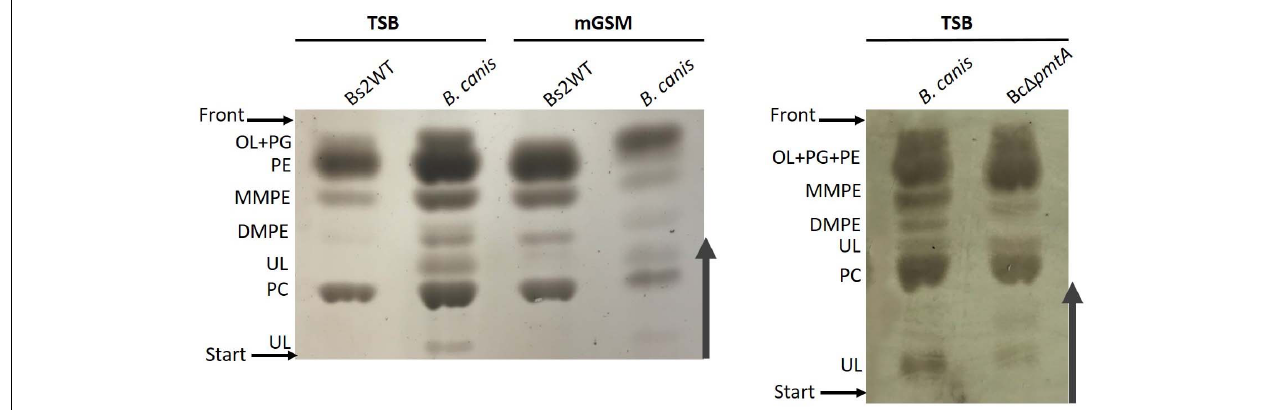
FIGURE 4 | High-performance thin-layer chromatography analysis of the free lipids of B. canis and Bc (cid:49) pmtA grown in TSB or mGSM. OL, ornithine lipids; PG, phosphatidylglycerol; PE, phosphatidylethanolamine; MMPE, monomethyl-phosphatidylethanolamine; DMPE, dimethyl-phosphatidylethanolamine; PC, phosphatidylcholine; UL, unknown